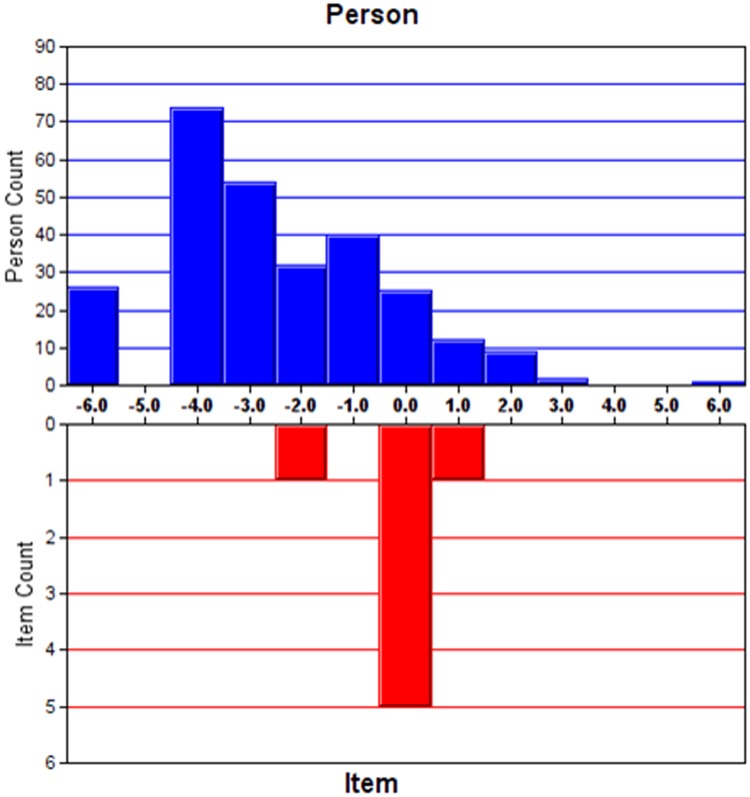
Person-item location distribution for HADS- Depression.